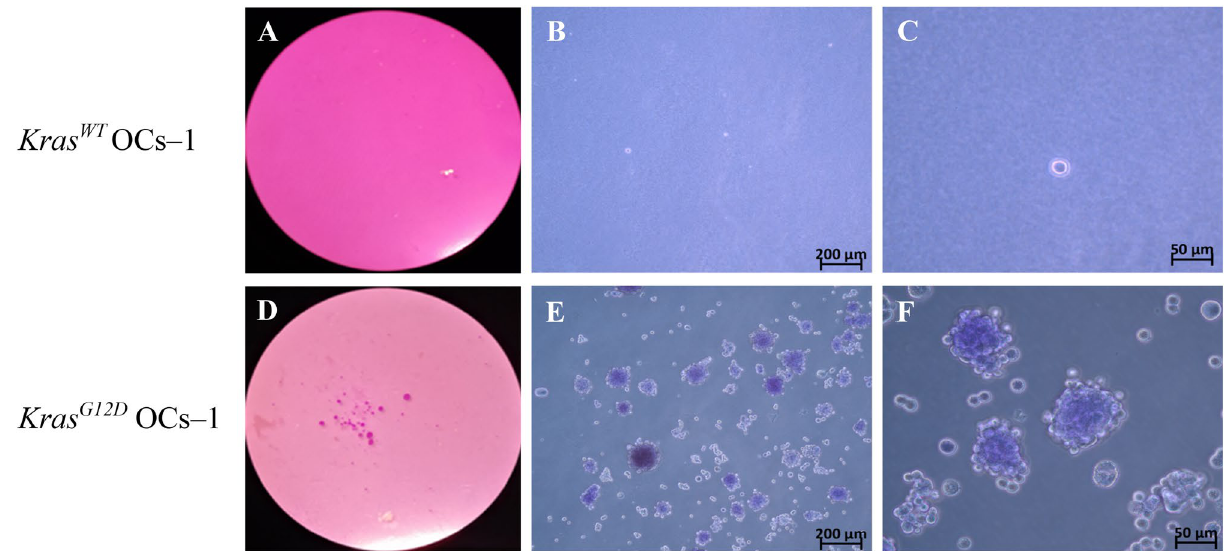
Figure 6. Noble Agar assay for Kras WT OCs-1 ( A – C ) versus Kras G12D OCs-1 ( D – F ). Photos by Loupe,